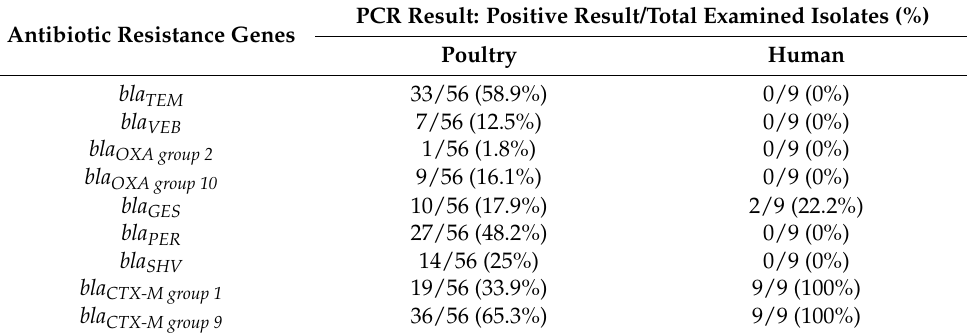
Table 5. PCR results of chicken (56) and human (9) samples for detection resistance-associated genes.